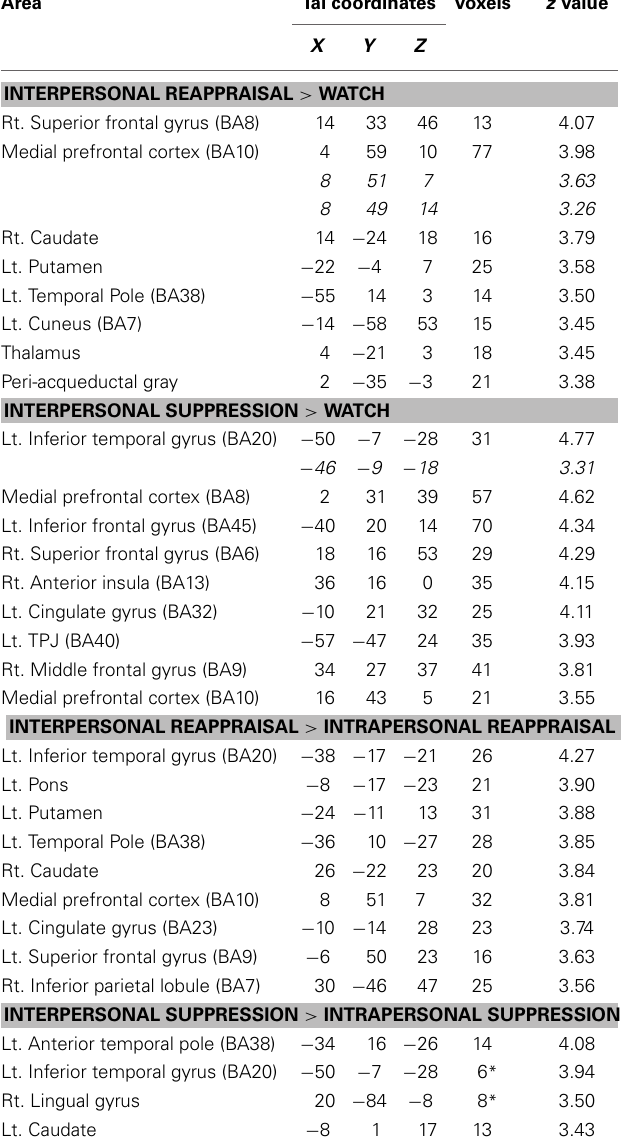
Table 6 | Areas activated by interpersonal emotion regulation. Area Tal coordinates Voxels